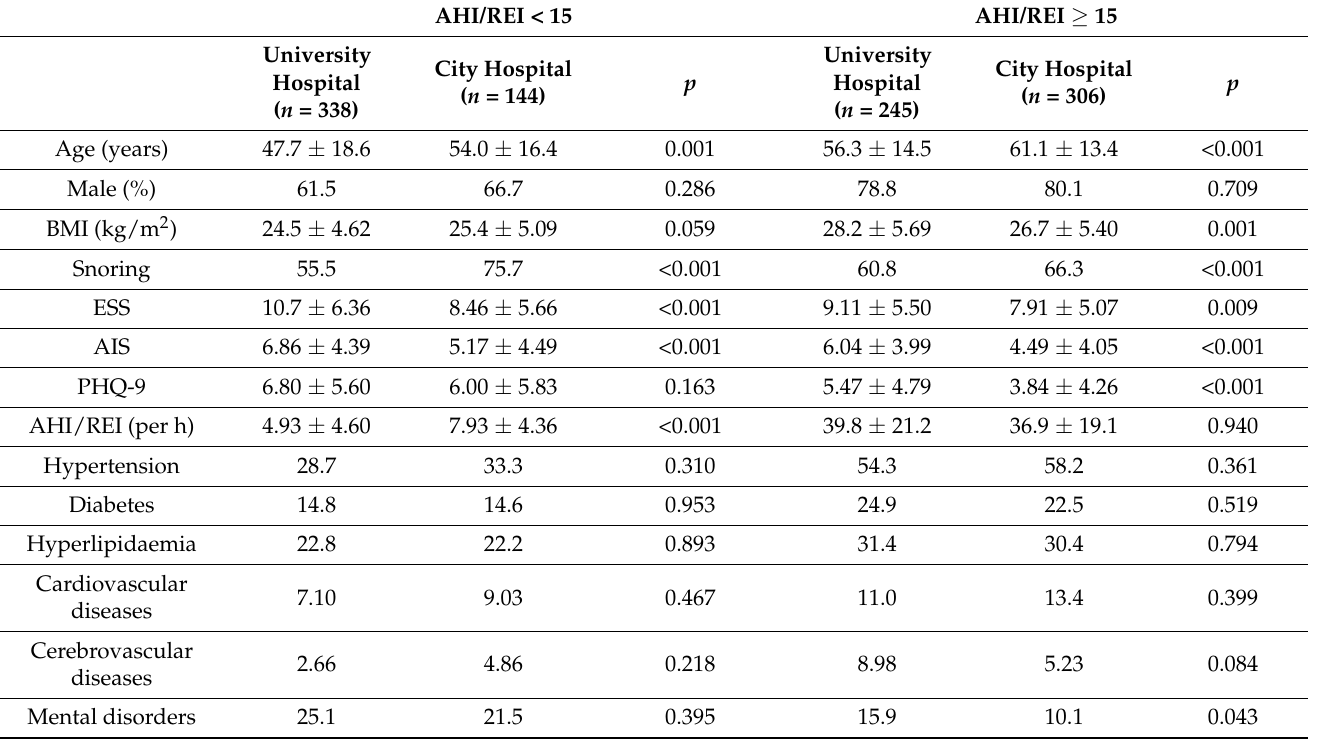
Table 2. Characteristics of patients with no to mild OSA (AHI/REI < 15) vs. moderate to severe OSA (AHI/REI ≥ 15) in the two settings.